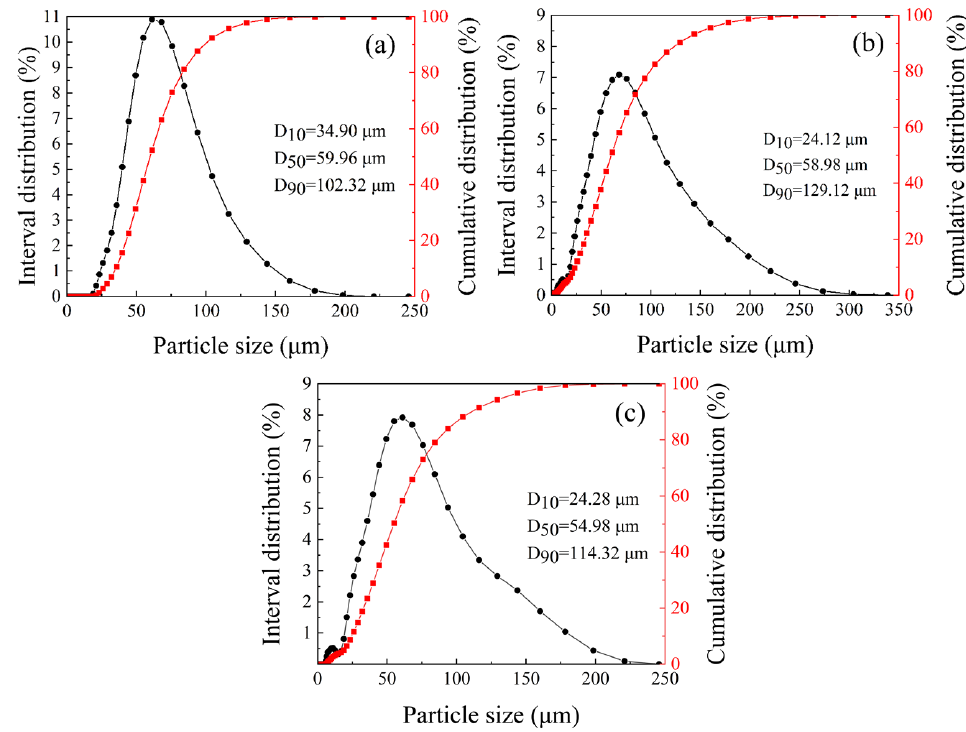
Figure 3. Particle size distribution of the test samples: ( a ) graphite; ( b ) mica; and ( c ) quartz.